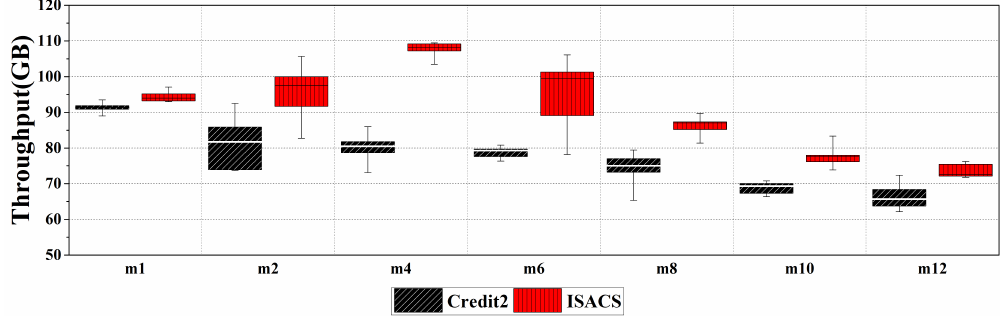
Figure 10. Distribution of the network throughput of each scheduler for 15 iterations of each experiment according to the VM configurations in a mixed environment. Table 6. Average network throughput according to the VM configuration based on Figure 10. Mixed